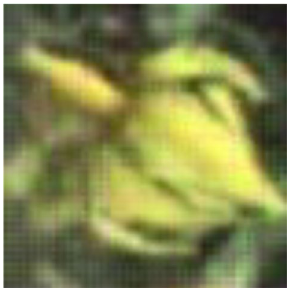
Figure 14. Low-resolution camera images intended for implementation on ultra-compact